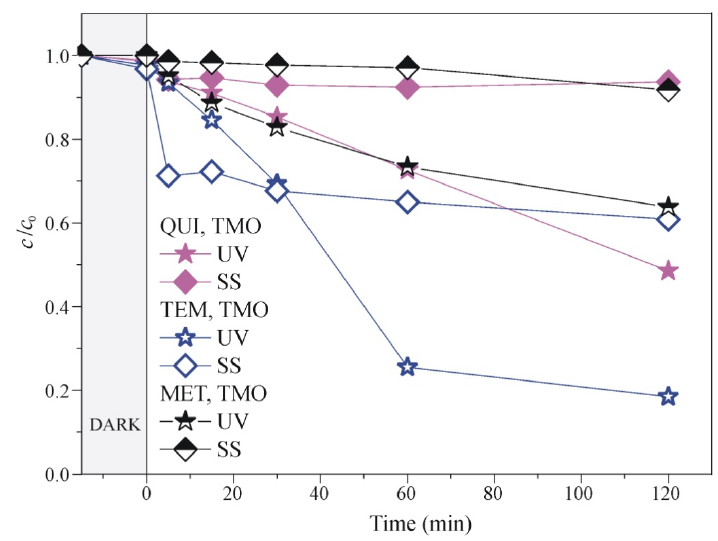
Figure 8. Effect of radiation type on the efficiency of QUI, TEM, and MET (0.05 mmol/dm 3 ) removal using the TMO (1.0 mg/cm 3 ) photocatalyst at pH